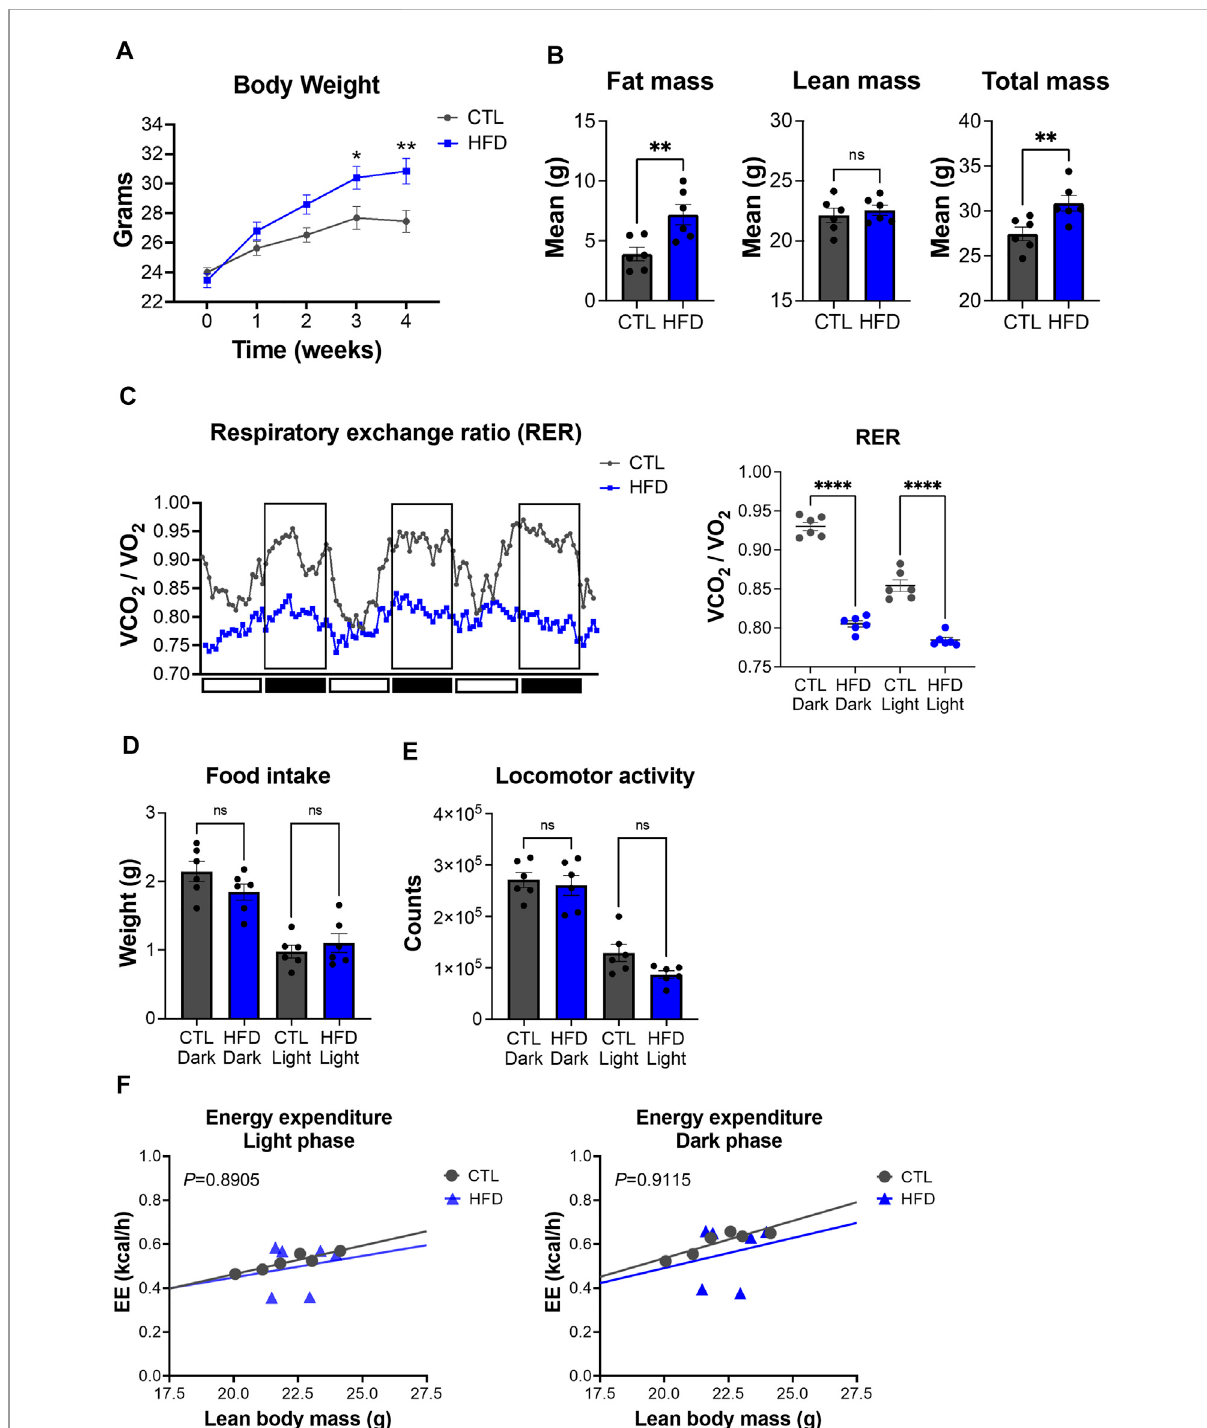
FIGURE 3 MetabolicphenotypingofamousemodelofDIO. (A) Bodyweightoverthecourseof4 weekswithfeedingoflow-fatcontroldiet(CTL)orHFD. Data represent the mean ± SEM with p value cutoff indicated as * p < 0.05 and ** p < 0.01 as determined by two-way ANOVA. (B) Fat, lean, and total mass measurements at 4 weeks after feeding of CTL or HFD ( n = 6 mice per group). Data represent the mean ± SEM with p value cutoff indicated as ** p < 0.01 determined by Student ’ s t -test. (C) (Left) RER (VCO 2 /VO 2 ) in CTL and HFD fed mice over 3 days. (Right) Quanti fi cation of the mean RERinCTLandHFDfedmiceover4 days( n =6mice).Datarepresentthemean±SEMwith p valuecutoffindicatedas**** p < 0.0001asdetermined by one-way ANOVA. (D) Food intake in CTL and HFD fed mice over 4 days ( n = 6). Data represent the mean ± SEM and statistical signi fi cance was